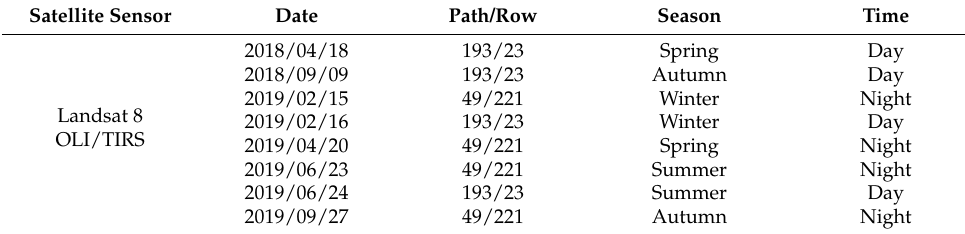
Table 1. Data source information on remote sensing